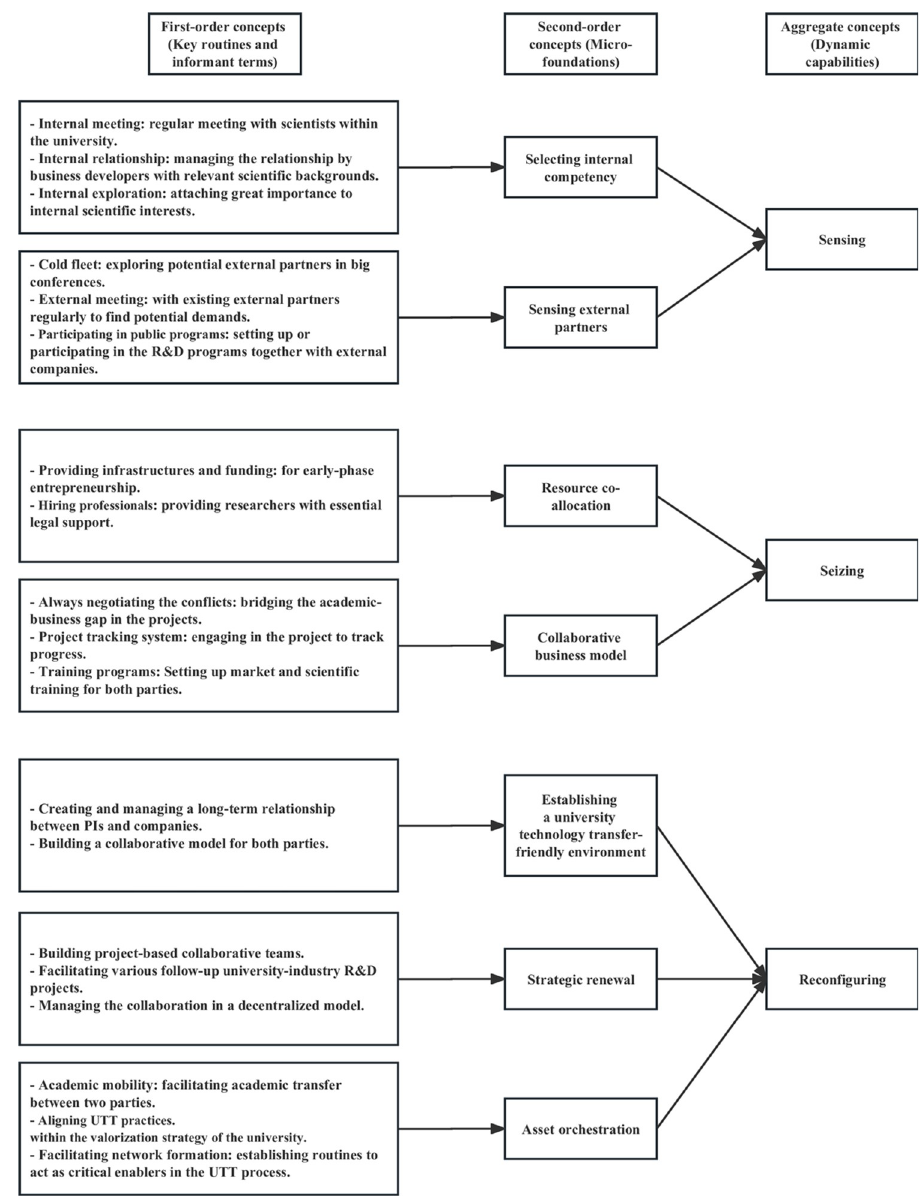
Fig 1. Structure of the empirical